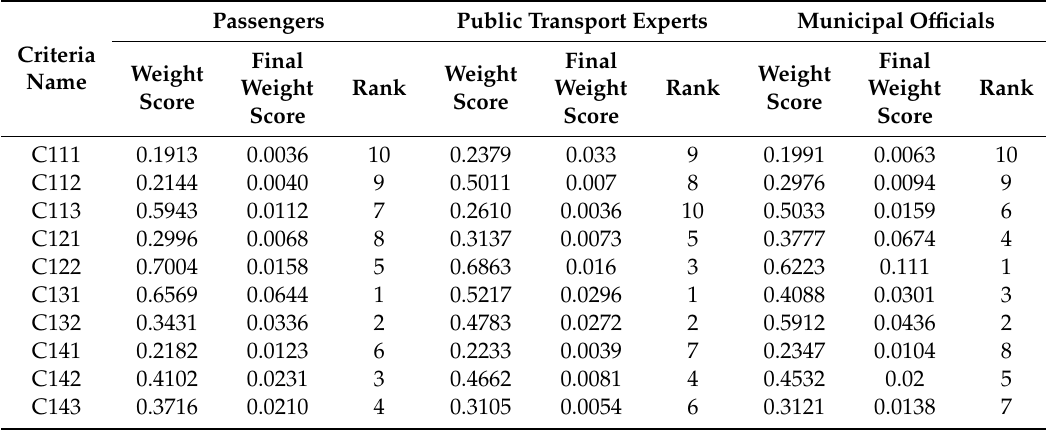
Table 9. The final weight and ranks for the factors in the third